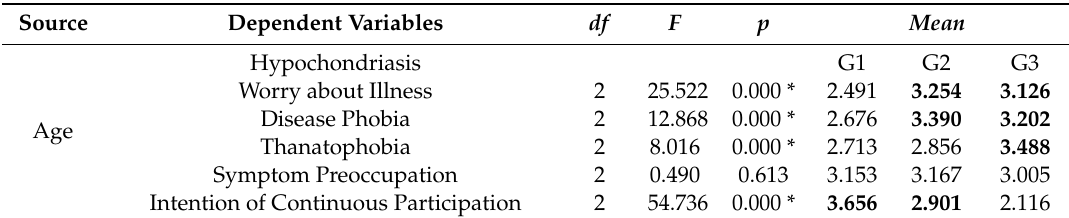
Table 3. Results of main e ff ect (age) on dependent variables.